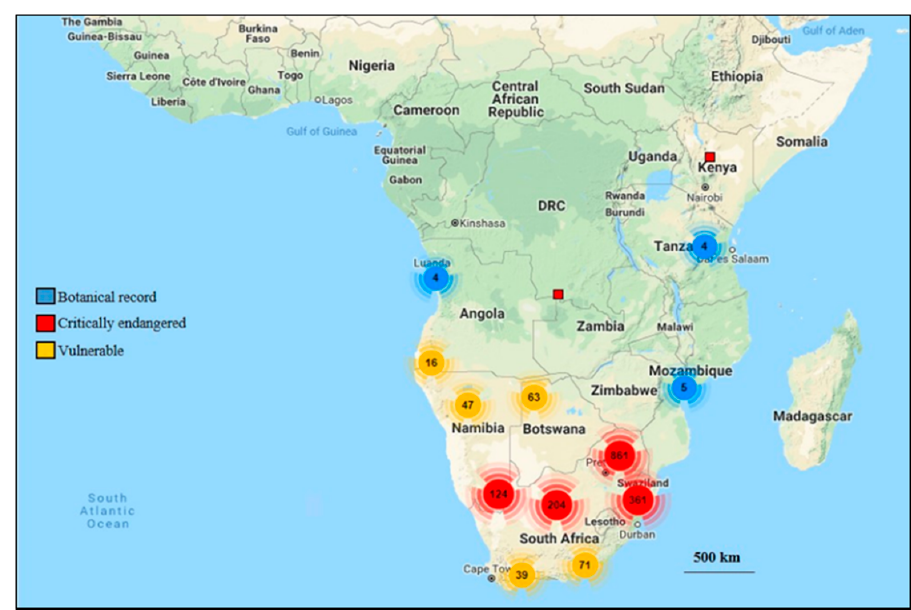
Figure 2. Distribution map of species of Barleria in Africa. Adapted from SANBI BRAHMS online (http://newposa.sanbi.org/sanbi/Explore) (Accessed- 14 June 2021).